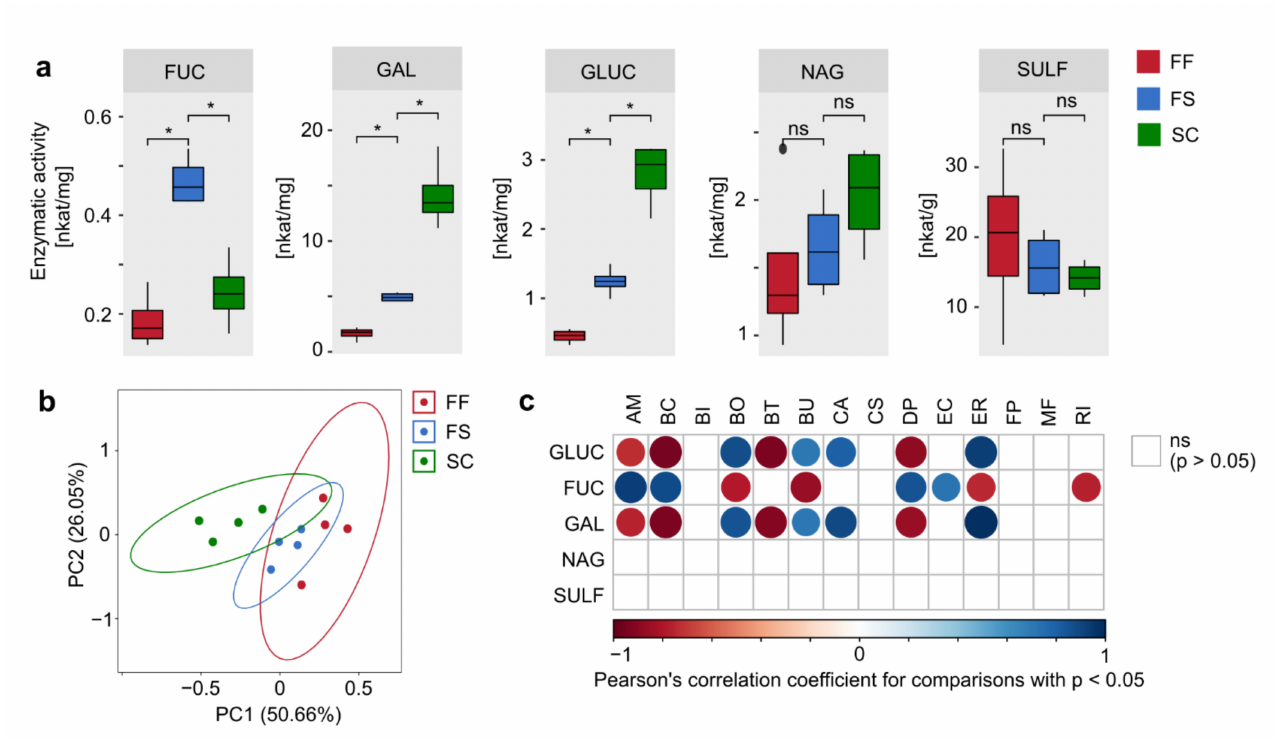
Figure 4. Concentrated raw fiber supplementation results in increased activity of bacterial fiber-degrading enzymes. ( a ) Tukey boxplots of enzymatic activities of bacterial glycan-degrading enzymes in fecal samples, normalized on the amount of total fecal protein; FUC: α -fucosidase, GLUC: β -glucosidase, GAL: α -galactosidase, NAG: β - N -acetlyglucosaminidase, SULF: sulfatase; statistics: Wilcoxon rank sum test performed with the “compare_means” function within the R package “ggpubr”. *: p < 0.05. ( b ) PCA plot of the glycan-degrading enzyme activity pattern of FF-, FS- and SC-fed mice as calculated with the “prcomp” function within the R package “stats”, using data sets shown in ( a ) and based on a Euclidian distance matrix. Visualization using the “autoplot” function. ( c ) Pairwise correlation between glycan-degrading enzyme activities and the relative abundance of 14SM strains from all mice across all groups. Analysis performed using the “rcorr” function of the R package “Hmisc” and visualized using the “corrplot” function. Colored circles depict statistically significant correlations ( p < 0.05); empty squares represent non-significant correlation; color intensity and circle size vary depending on the Pearson correlation coefficient R, with R = 1 (positive correlation) and R = − 1 (negative correlation) displayed with maximal circle size and color intensity. AM: A. muciniphila , BC: B. caccae , BI: B. intestinihominis , BO: B. ovatus , BT: B. thetaiotaomicron , BU: B. uniformis, CA: C. aerofaciens , CS: C. symbiosum , DP: D. piger , EC: E. coli , ER: E. rectale , FP: F. prausnitzii , MF: M. formatexigens , RI: R. intestinalis